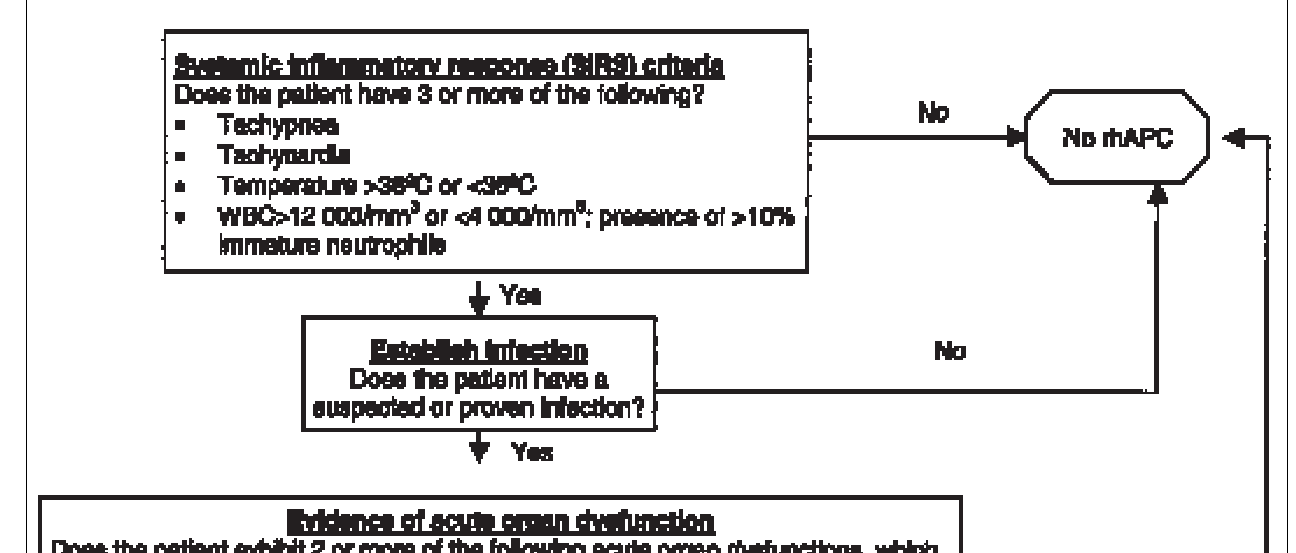
Fraction of inspired 2